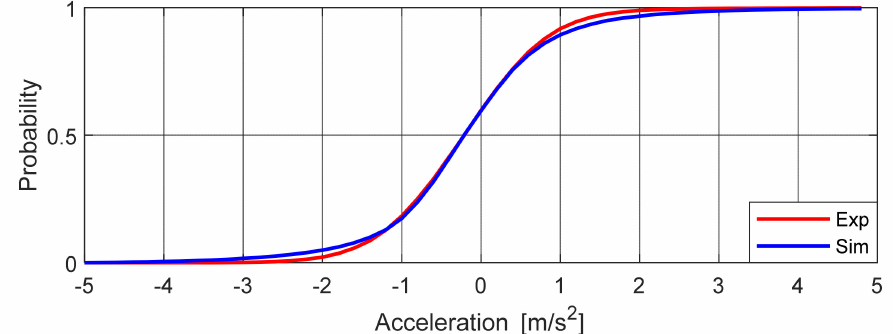
Figure 26. Distribution function, acceleration on vehicle RA. The comparison of PDSs in the frequency range of 0–10 Hz is made in Figure 27.